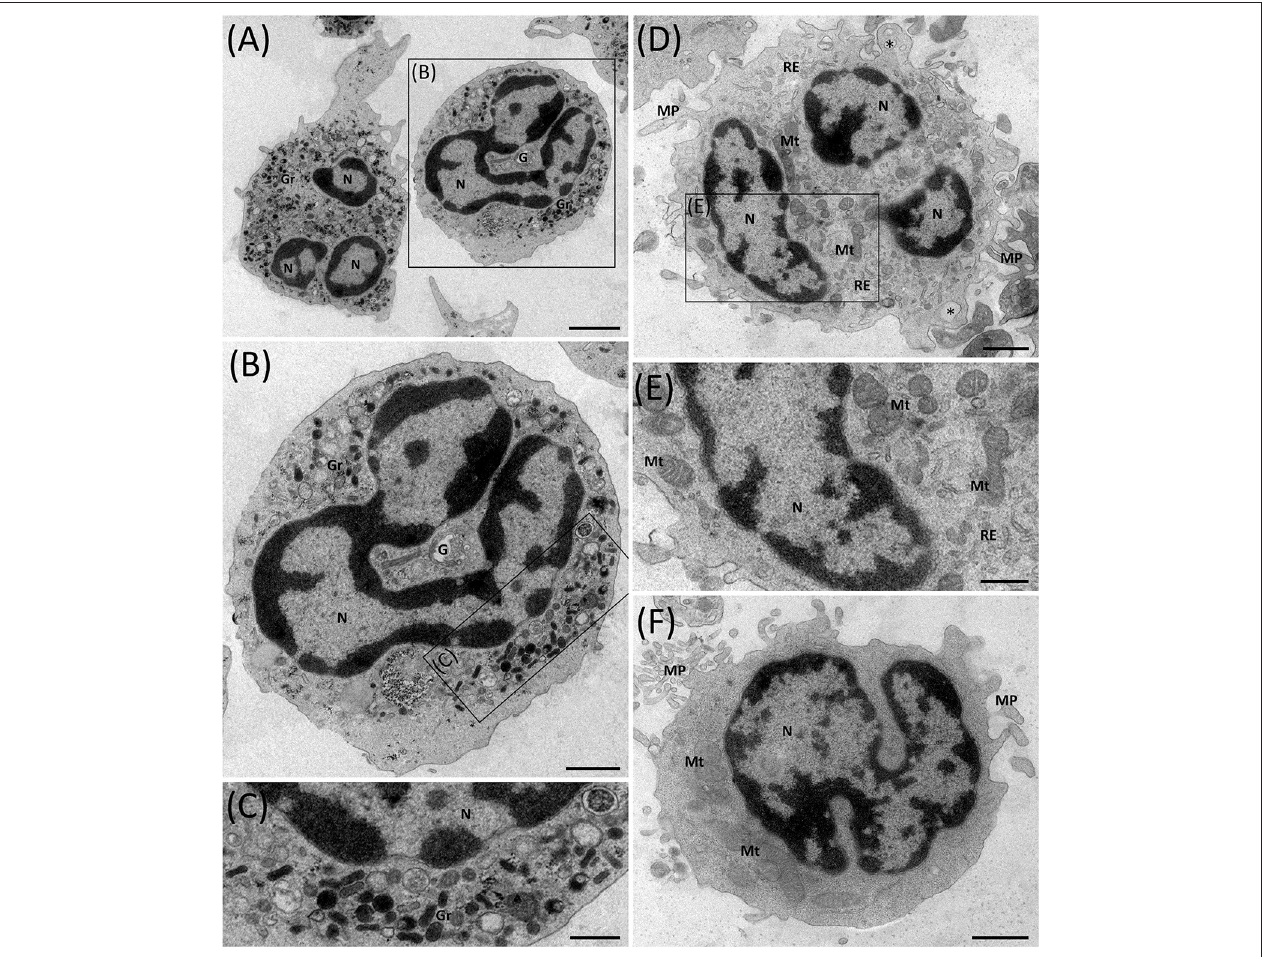
FIGURE 7 | Ultrastructure of ENL HDNs and LDNs as seen via transmission electron microscopy. (A–C) HDNs contain typical lobulated nuclei (N) with a large amount of highly condensed heterochromatin (electron-dense region) at the periphery and various types of cytoplasmic granules (Gr), variable in size, shape, and electron-density. Image representative of three ( n = 3) ENL patients. (D–F) LDNs possess lobulated nuclei, very few cytoplasmic granules, several mitochondrial (Mt), and endoplasmic reticulum (ER) profiles, membrane projections (MP), and empty vesicles (asterisks). Images representative of six ( n = 6) ENL patients. G, Golgi complex. Bar = 2 µ m (A) , 1 µ m (B,D,F) and 500nm (C,E)